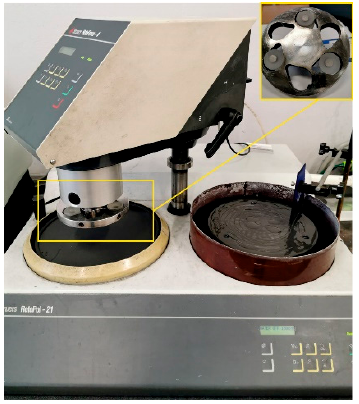
Figure 3. A stand for measuring of the 2- and 3-body abrasive wear resistance.